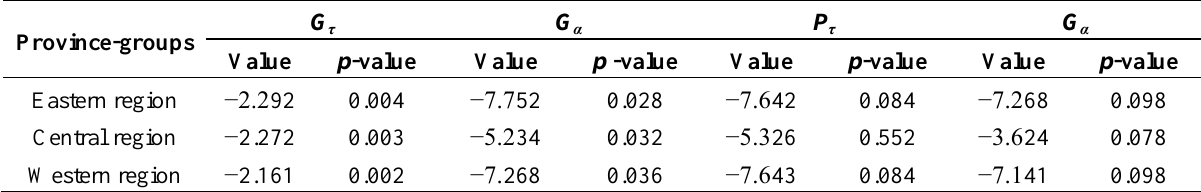
Table 3. Results of the cointegration tests for cross sectionally dependent